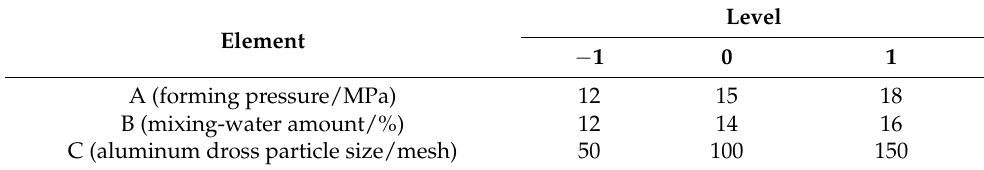
Table 2. Factors and level encoding of response surface development experiment.